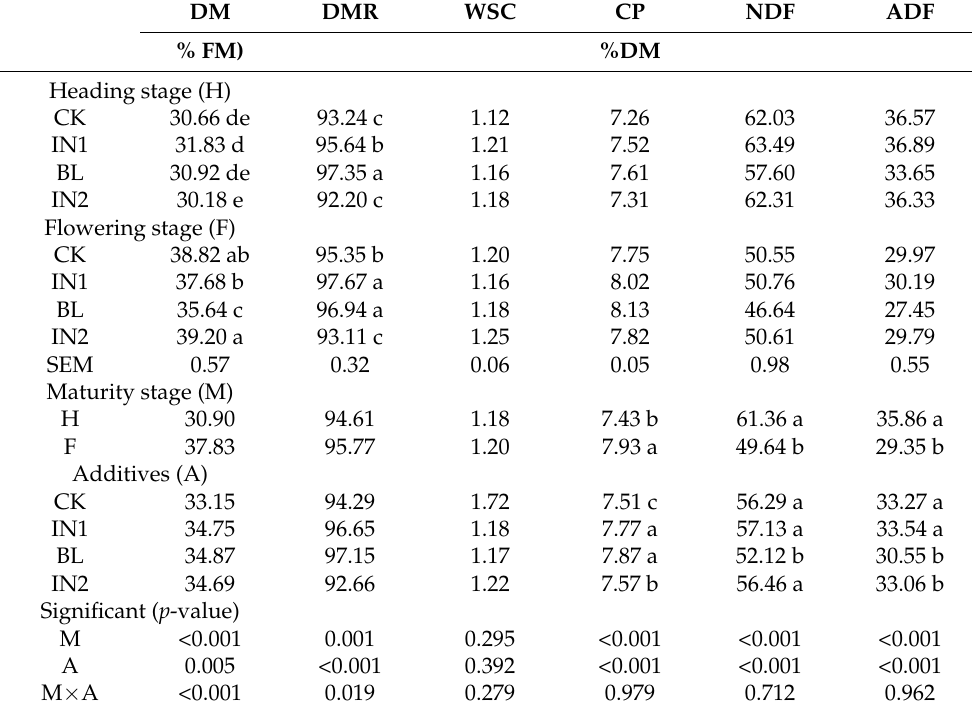
Table 2. Chemical composition of perennial oat silages treated without (CK) or with local LAB inoculant (IN1), commercial LAB inoculant (IN2), and sodium benzoate (BL).